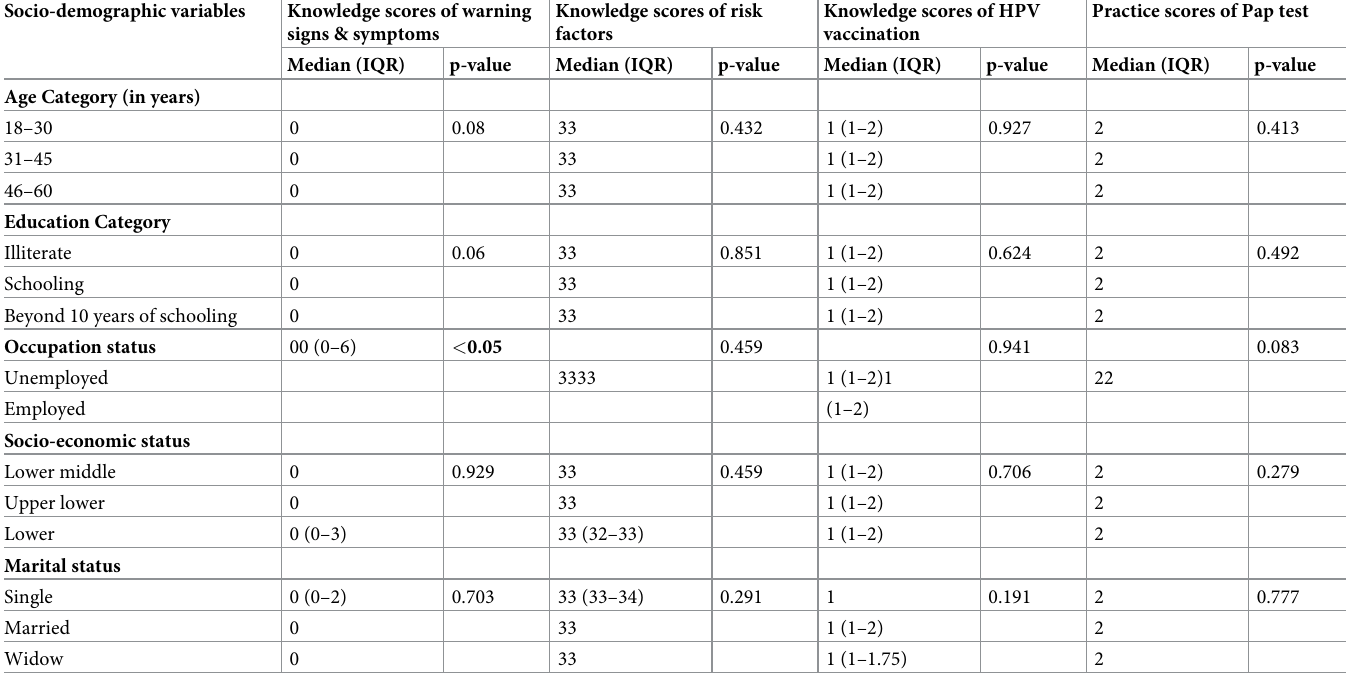
Table 4. Comparison between median knowledge scores of warning signs and symptoms, risk factors of cervical cancer and HPV vaccination and median practice scores of Pap test across socio-demographic variables before mHealth intervention (n =